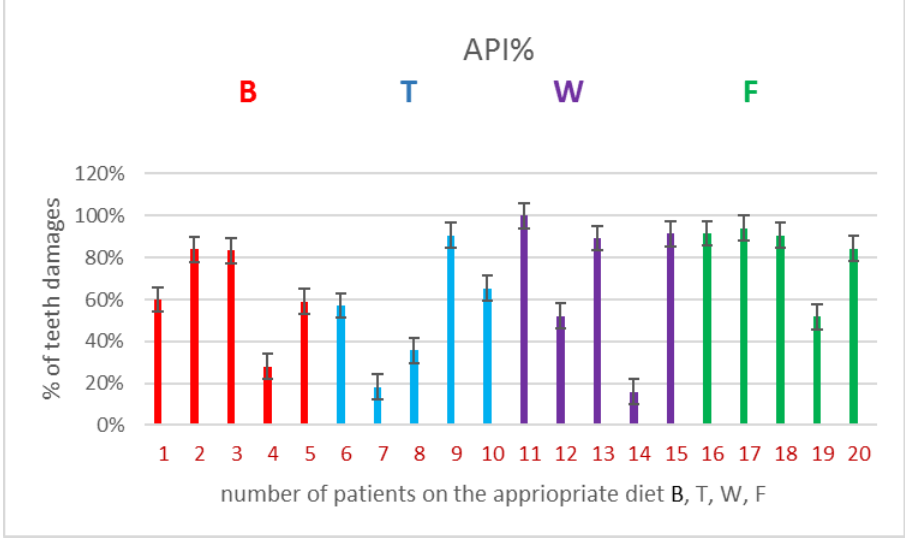
Figure 2. Examples of 4 types of diets used on the selected API indicator (see Table 2. in Results).